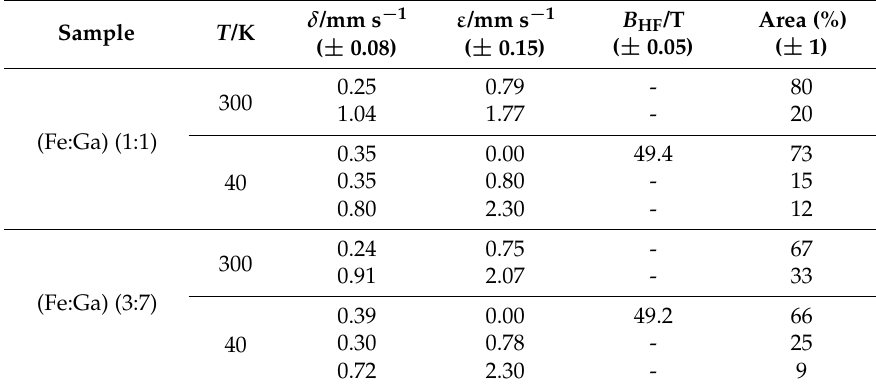
Table 1. 57 Fe Mössbauer parameters: isomer shift ( δ ), quadrupole shift ( ε ), hyperfine interaction ( B HF ) and total area for different Fe-related phases in Fe substituted γ -Ga 2 O 3 materials with Fe:Ga 1:1 and Fe:Ga 3:7.